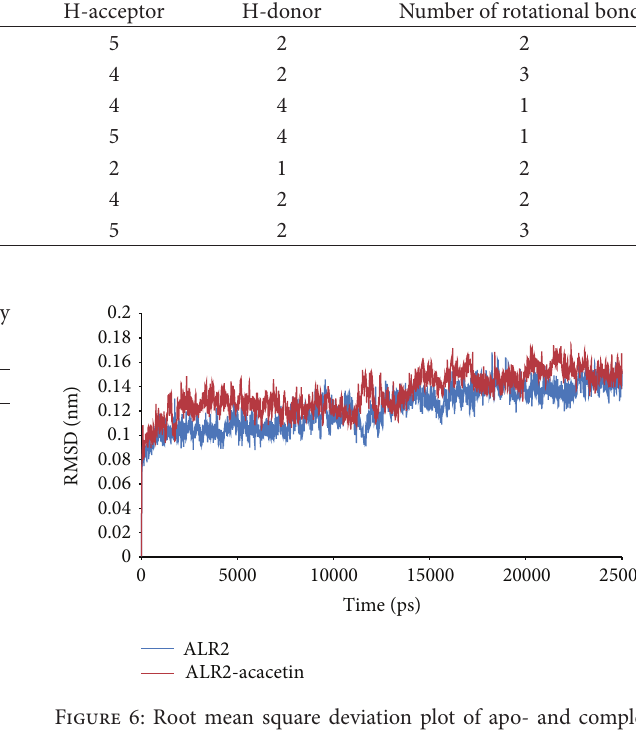
Figure 6: Root mean square deviation plot of apo- and complex ALR2 from molecular dynamics simulation after 25 ns production run.